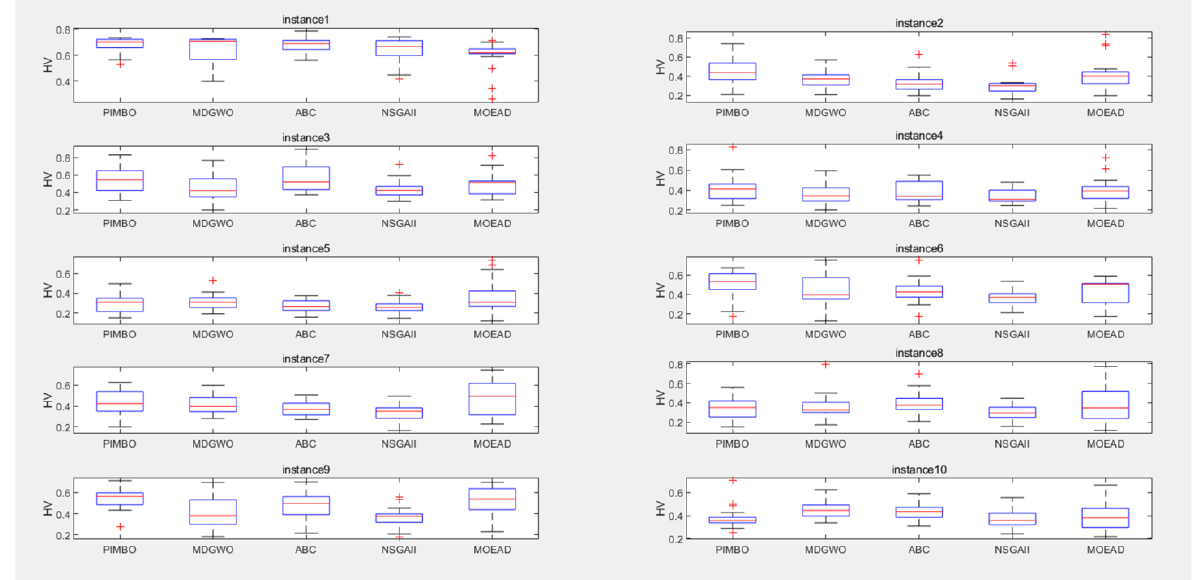
Figure A9. Boxplot of the experimental results of five algorithms via hypervolume metric.